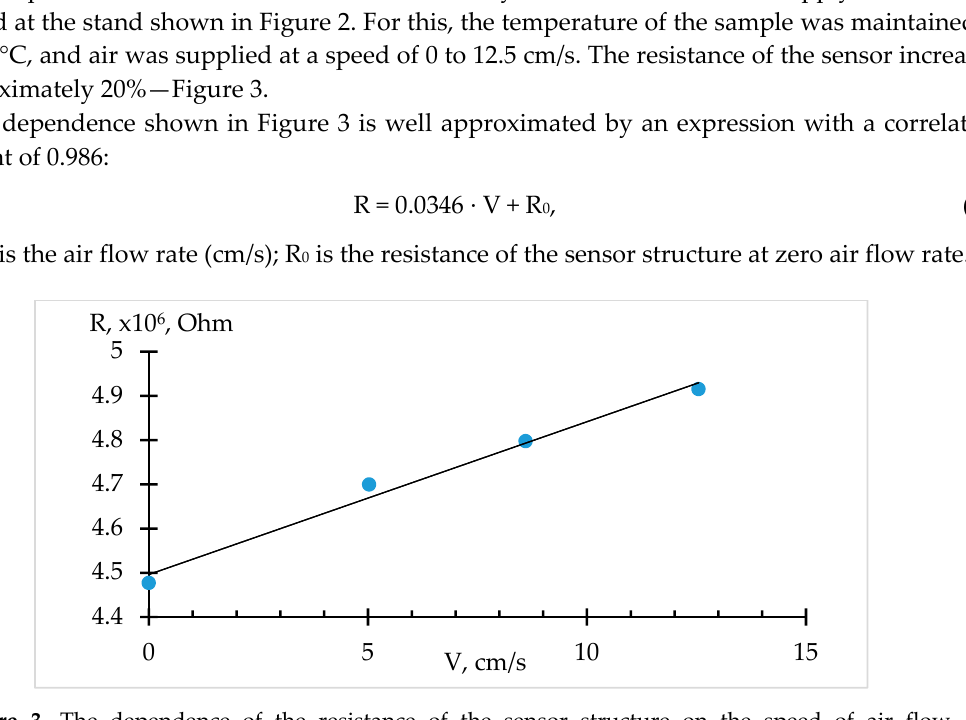
Figure 3. The dependence of the resistance of the sensor structure on the speed of air flow (points—experiment;